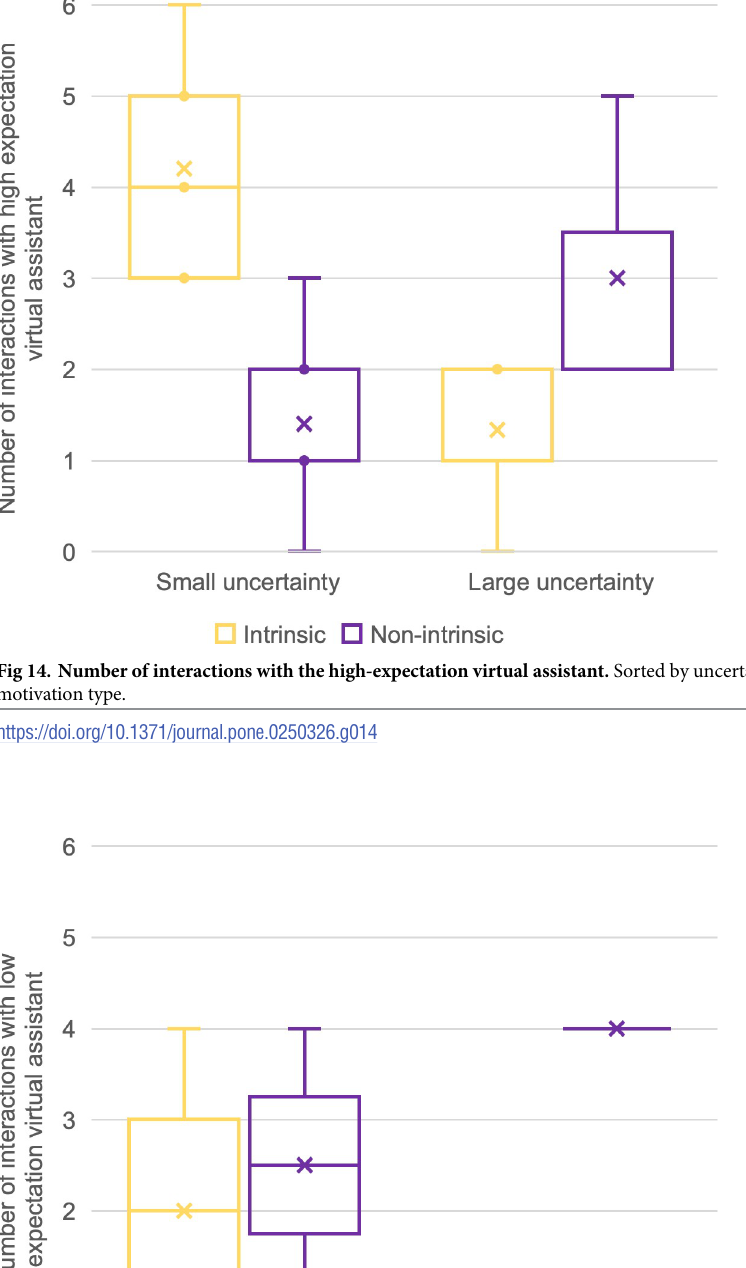
Fig 15. Number of interactions with the low-expectation virtual assistant. Sorted by uncertainty group and motivation type.